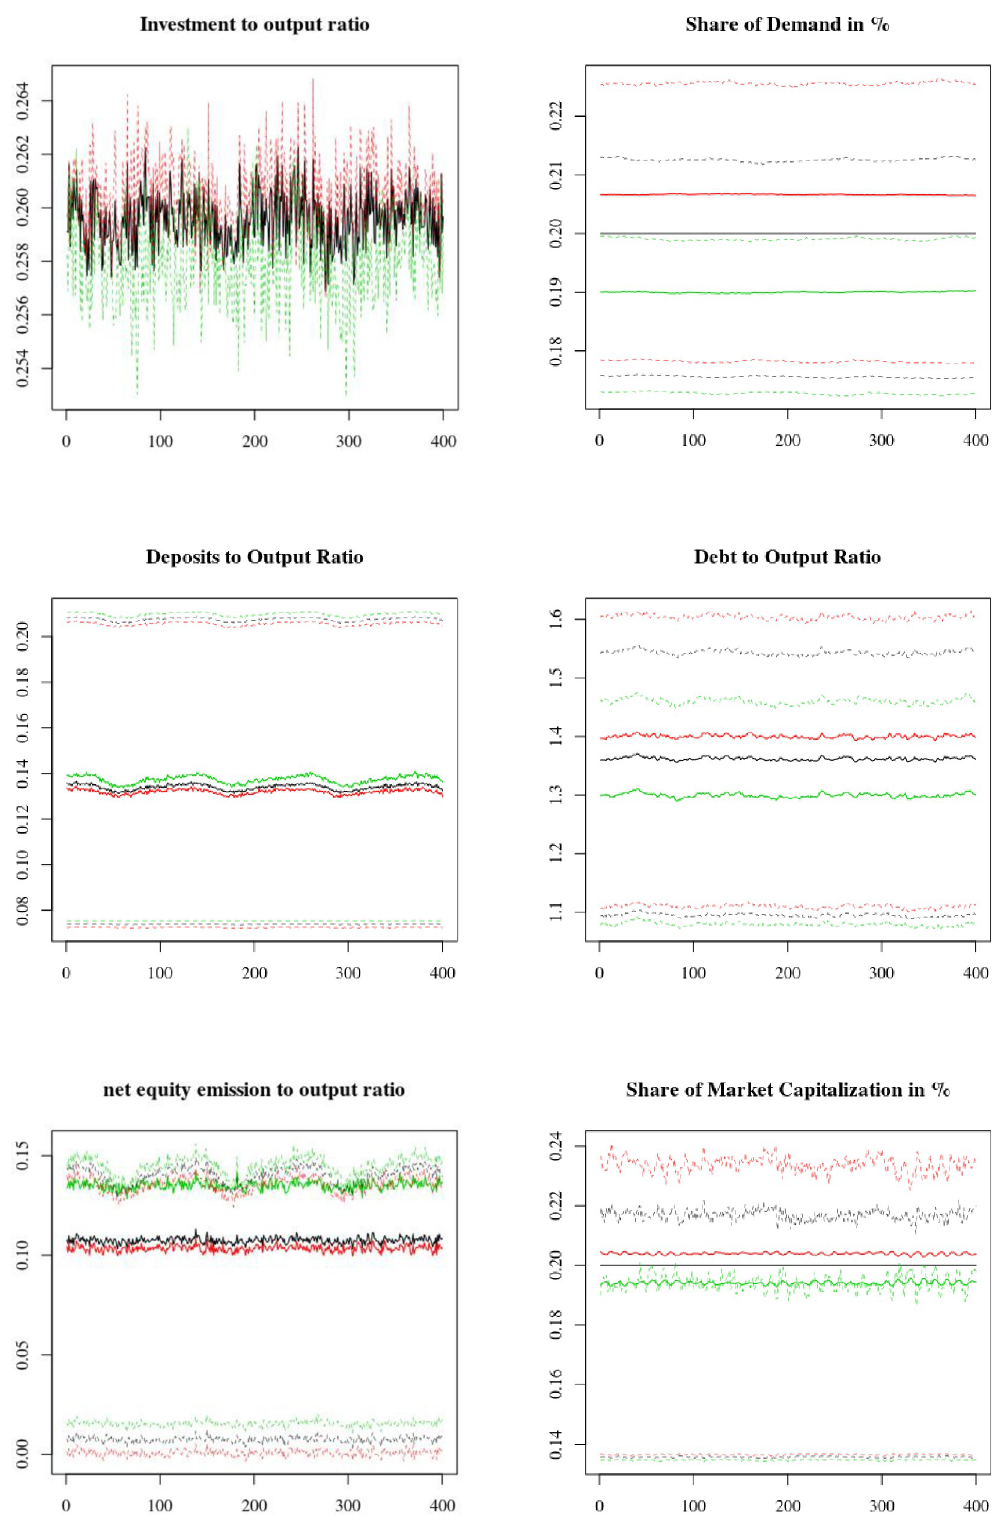
Fig 5. Selected microeconomic indicators. Average results, weighted by firms’ share of demand (black lines for average across all firms, red lines for overconfident firms and green lines for neutral firms). Means (thick solid lines) and quantiles at 25% and 75% (dotted